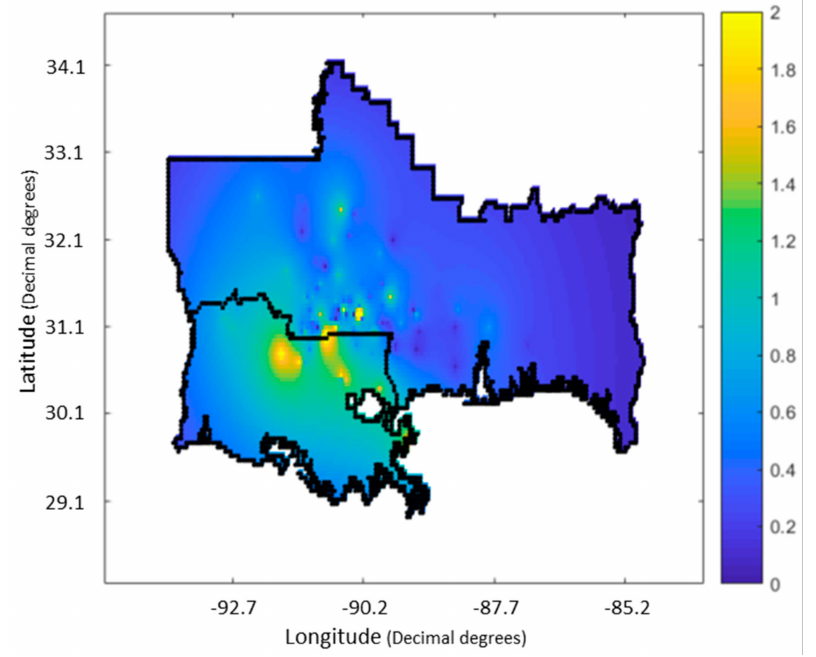
Figure 6. Spatial distribution of the mean TOC wt% values of the cumulative distribution function at each estimation point.